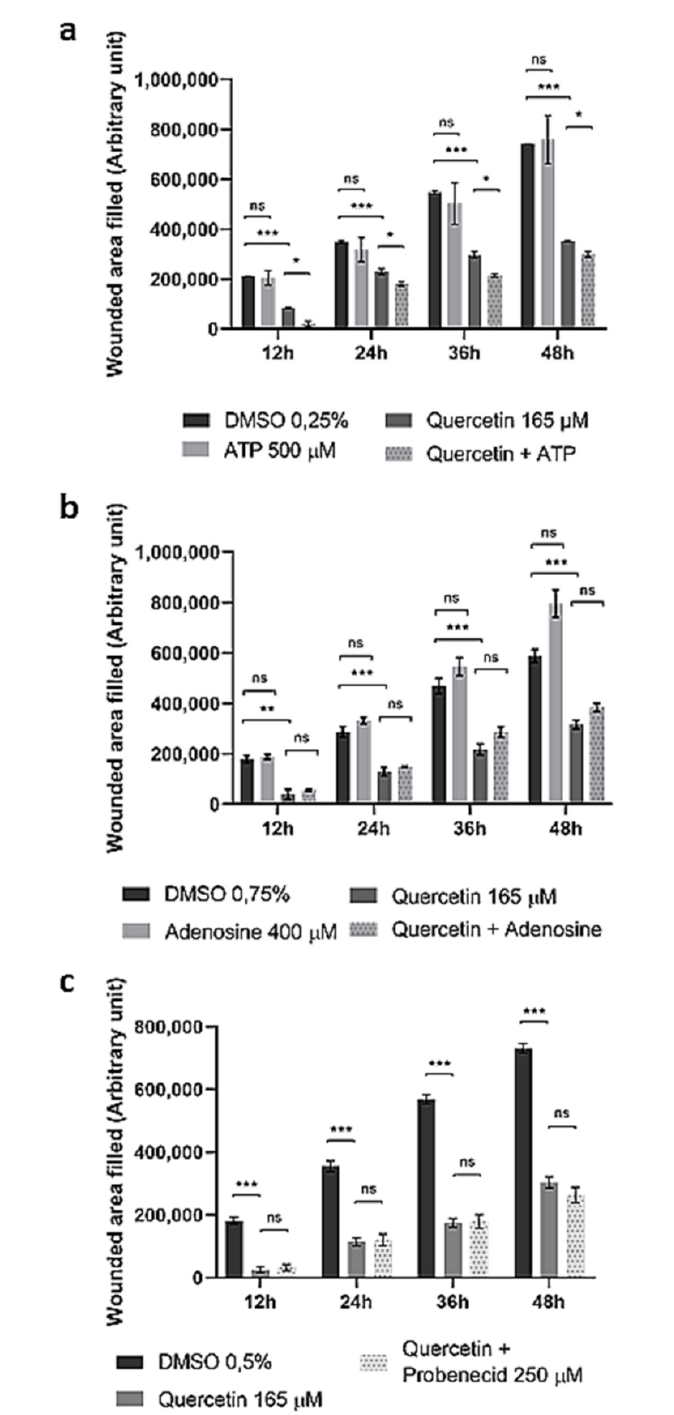
Figure 5. Effect of Quercetin on HepG2 cells’ migration rate. Cells were treated with Quercetin (165 µ M) for 12 h. Then, a scratch was made in the cell monolayer, and pictures were taken every 12 h, while the cells were still kept in contact with Quercetin. DMSO-treated cells were used as a control. ATP 500 µ M ( a ), Adenosine 400 µ M ( b ), or Probenecid 250 µ M ( c ) was added to both control and Quercetin-treated cells. Data are expressed as the mean and standard error of three different experiments. Statistical significance was assessed by multiple t test followed by Holm–Sidak correction for multiple comparisons; * p < 0.05; ** p < 0.01; *** p < 0.001. Representative pictures of the scratches taken at different times are shown in Supplementary Figure